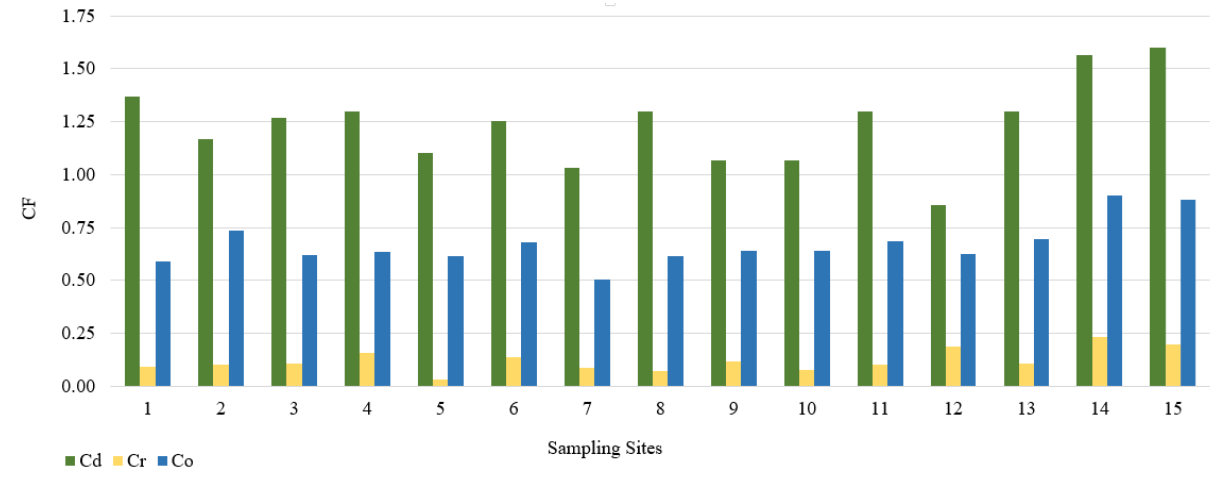
Figure 3. Value of the CF in bottom sediments of Pisa River and its tributaries.